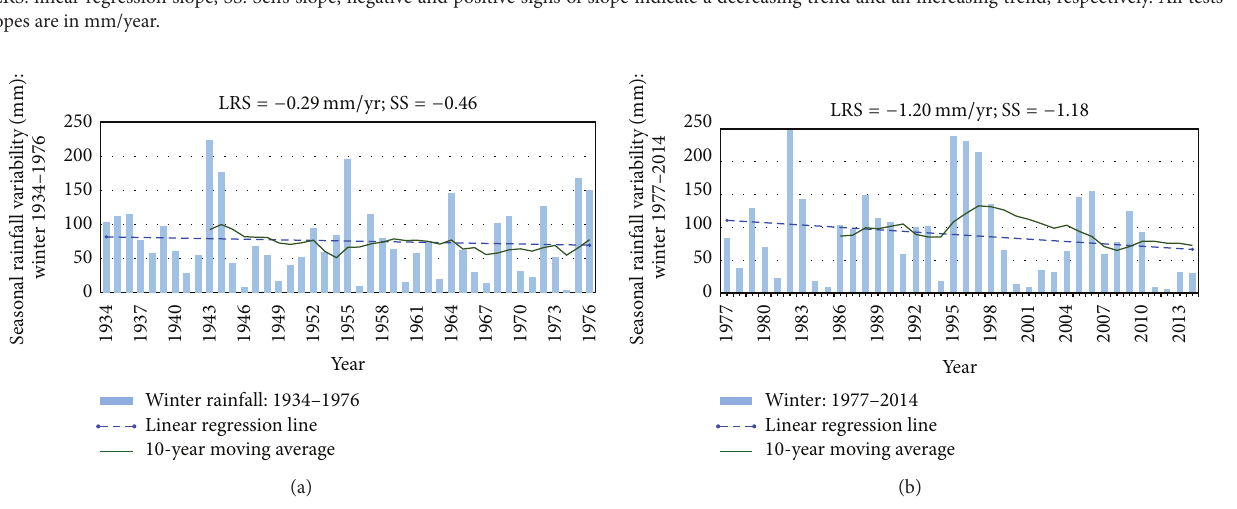
Figure 6: Long-term winter rainfall trends (dashed line) and 10-year moving average variability (solid line): (a) 1934–1976 period and (b) 1977–2014